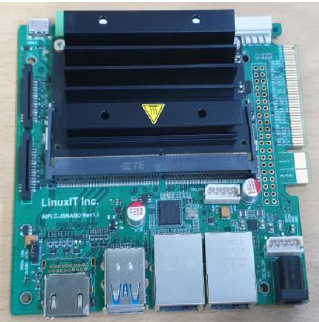
Figure 1. AI Edge-PLC Board.